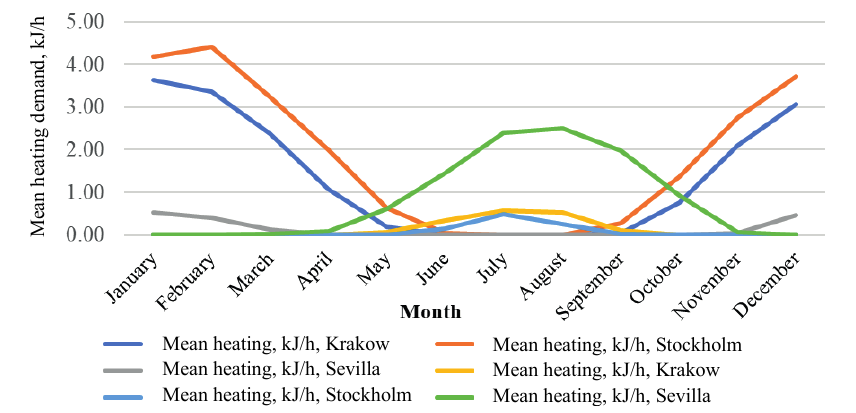
Fig. 4. Results of the mean heating and cooling